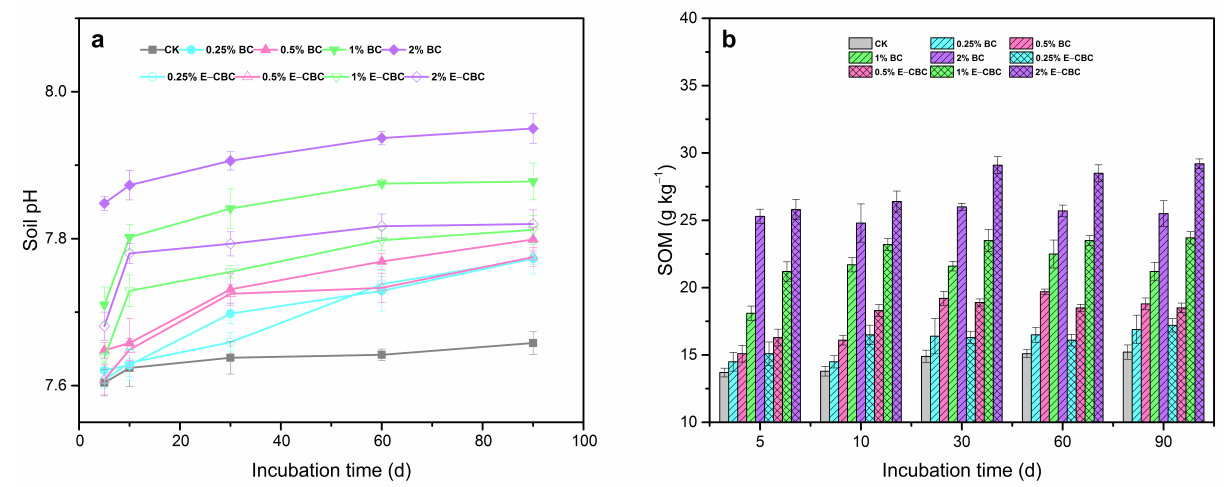
Figure 3. Effects of BC and E–CBC on soil pH ( a ) and SOM ( b